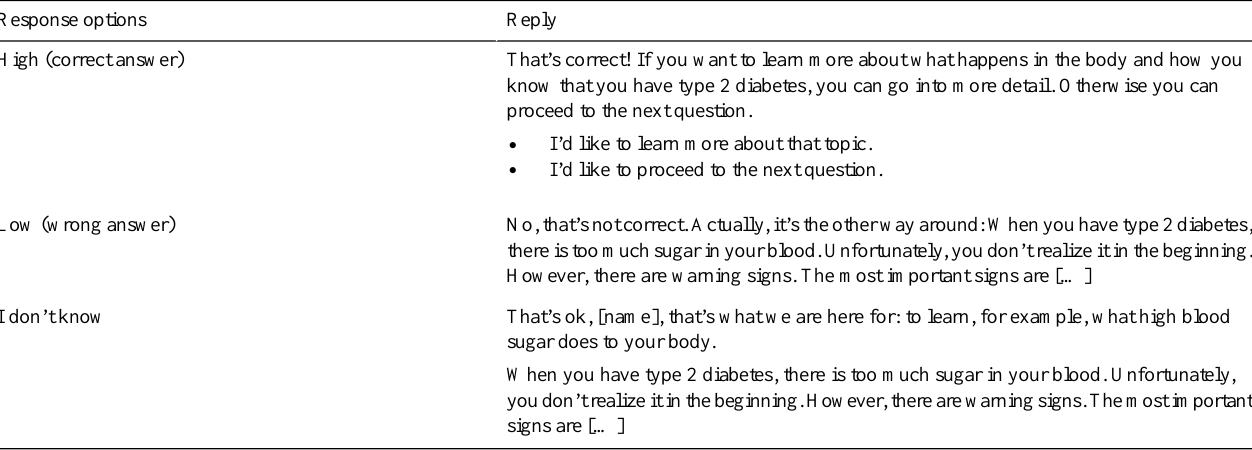
Table 2. Example of self-care tailoring: Response to “If you feel thirsty and urinate frequently, it usually means your blood sugar is…”. ReplyResponse